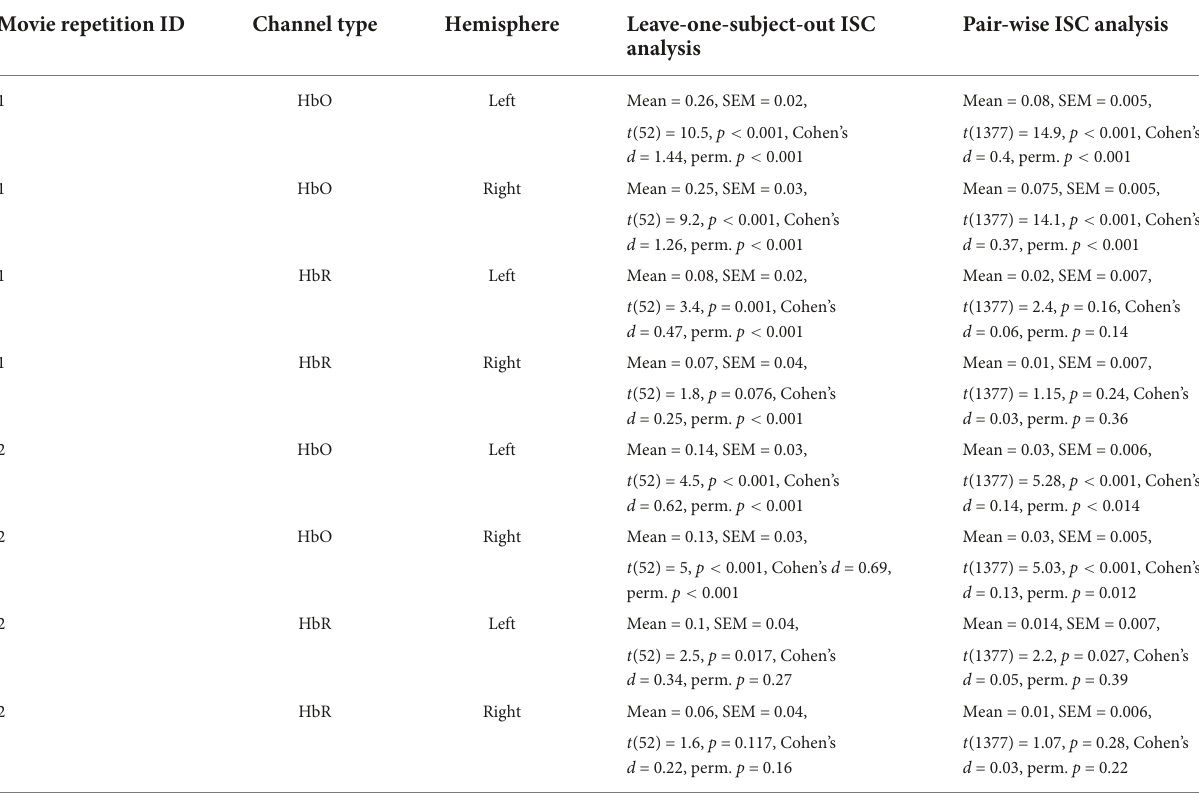
TABLE 1 Intersubject correlation (ISC) results for two repetitions of the movie bilateral oxygenated (HbO) and deoxygenated (HbR) fNIRS channels.